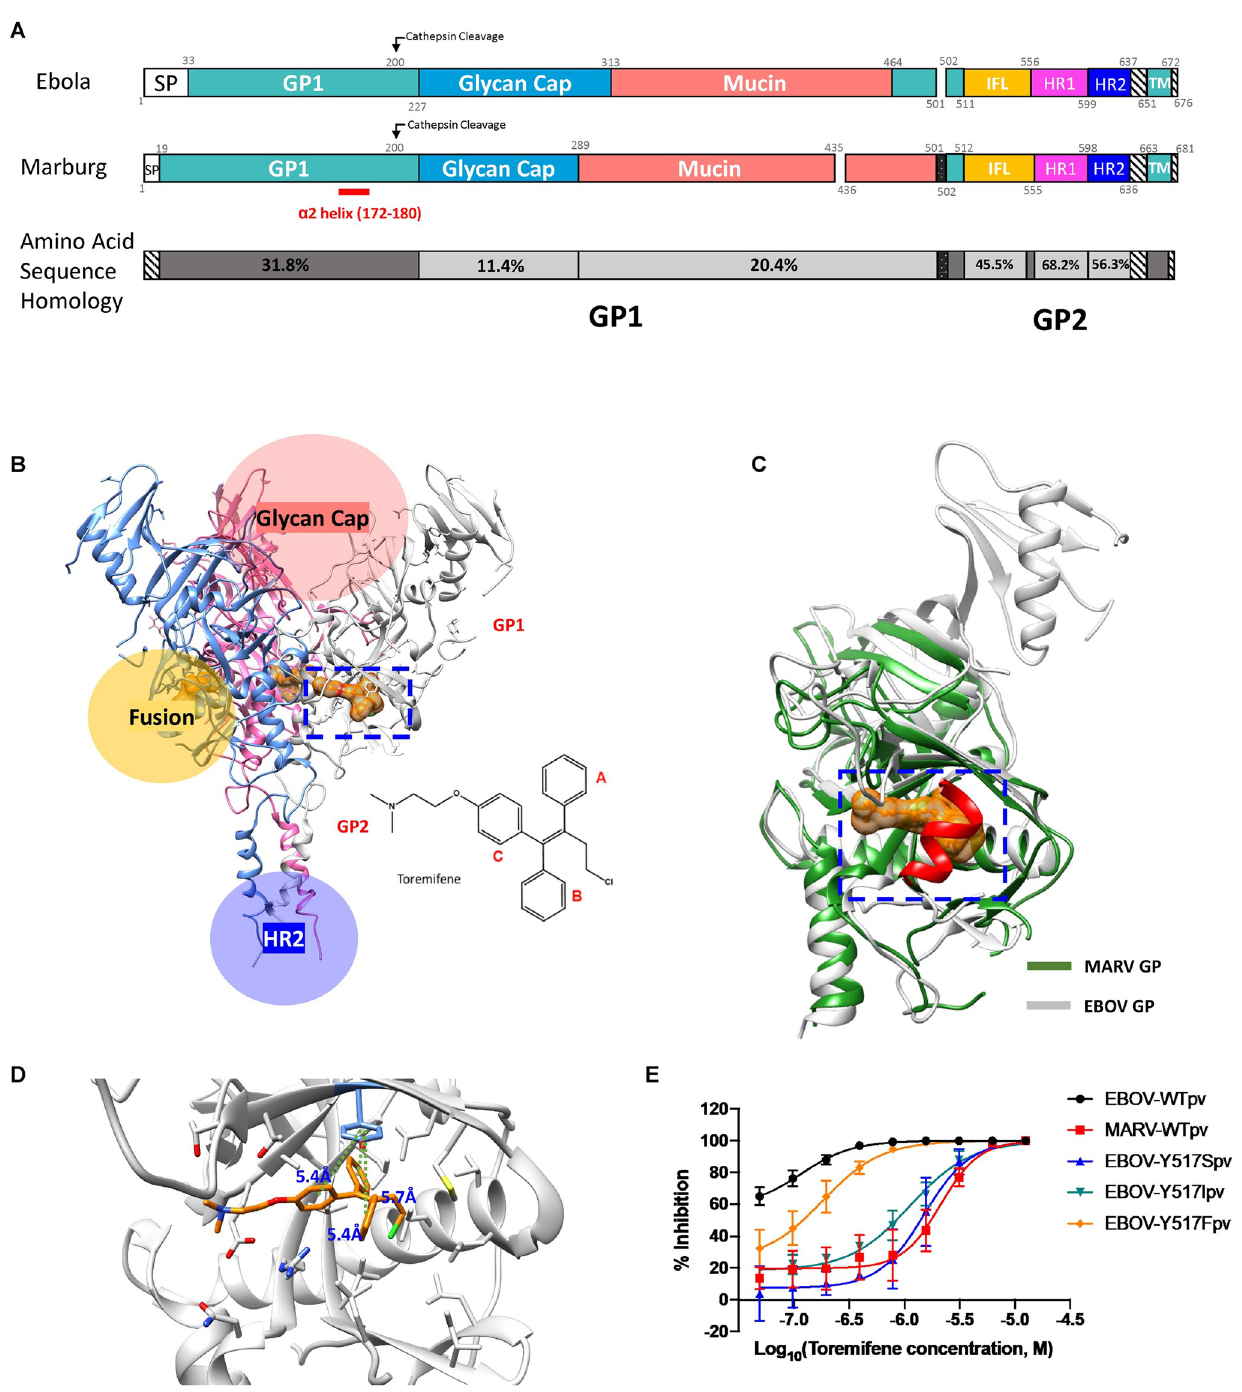
Fig 1. Structure of EBOV and MARV glycoproteins and mutational analysis of tyrosine 517 reveals a MARV-like phenotype. ( A ) Domain schematic of the EBOV and MARV GP and amino acid sequence homology between EBOV and MARV. Domains are numbered according to the crystal structure. Homology was determined using sequence alignment software (Geneious Prime 2019.2.1); ( B ) Co-crystal structure of Ebola virus (Zaire) glycoprotein complexed with toremifene (outlined by blue box, PDB: 5JQ7); ( C ) Overlay of the Ebola virus glycoprotein (white) with the Ravn virus glycoprotein (green, PDB: 6BP2) reveals an α -helix ( α 2) in marburgviruses that could block the drug-binding cavity (blue box); ( D ) The position of Tyrosine 517 (side chain is marked in light blue) in the fusion loop-associated binding pocket and estimated distances for π - π interactions with aromatic rings of Toremifene (distances for phenyl rings A, B, and C are 5.7 Å , 5.4 Å , and 5.4 Å , respectively); ( E ) Dose-response curves for toremifene against pseudotyped WT-EBOV, WT-MARV, and EBOV mutants Y517S, Y517I, and Y517F. Disruption of π - π interactions between EBOV Tyrosine 517 and toremifene produce a MARV- like dose-response curve. All error bars represent s.d. from three independent experiments.